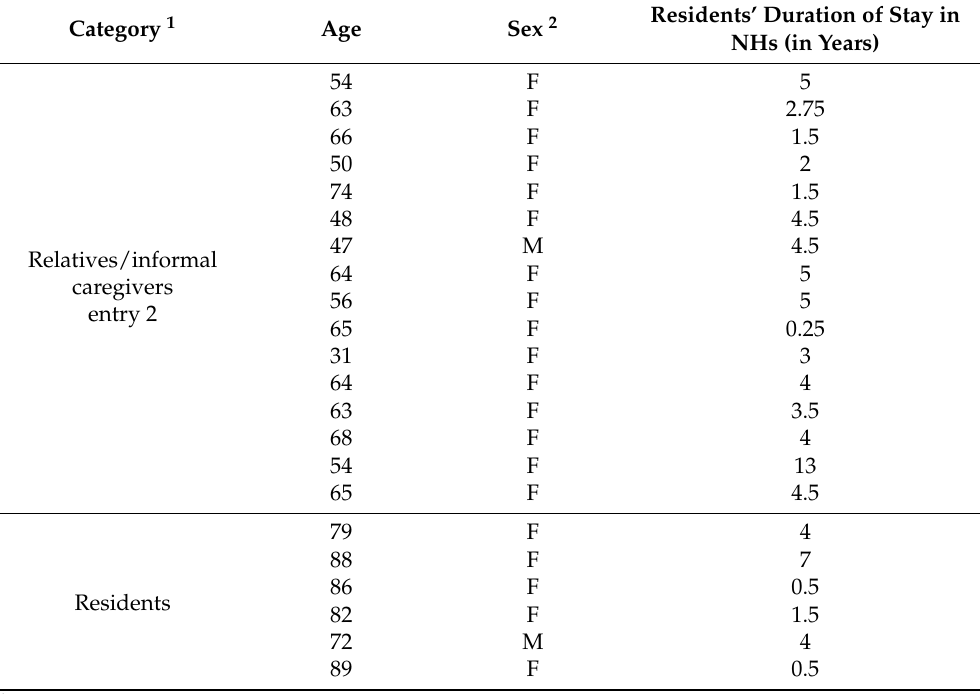
Table 1. Sample description: relatives and residents.